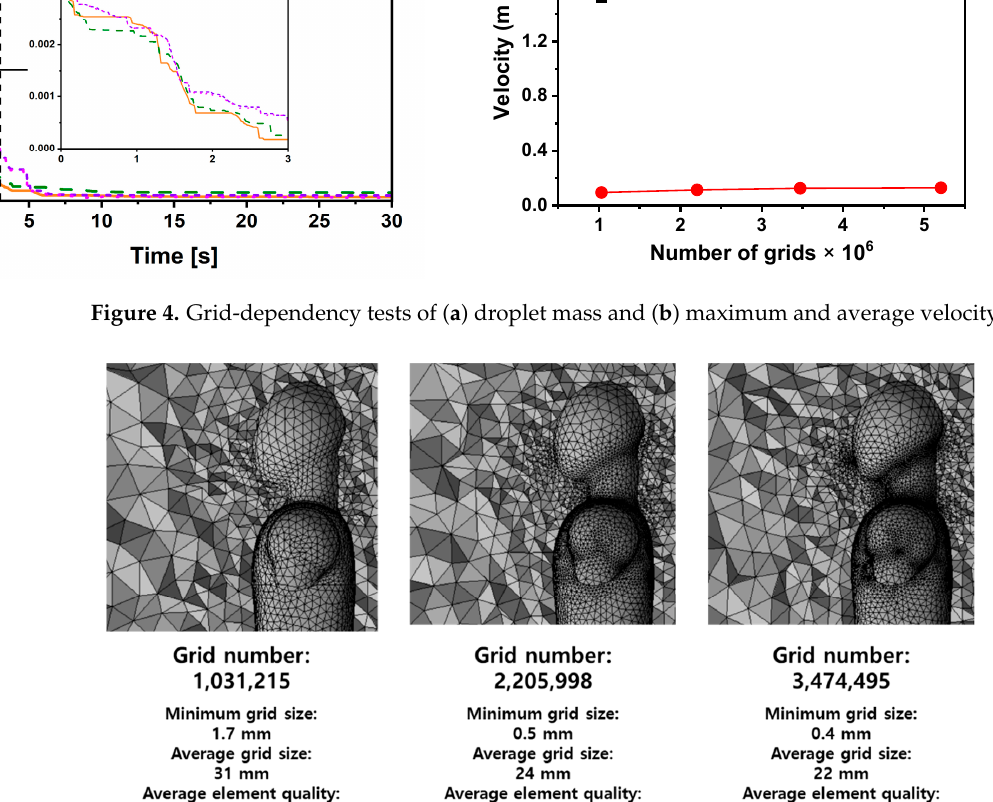
Figure 5. Mesh characteristics of simulation domains.